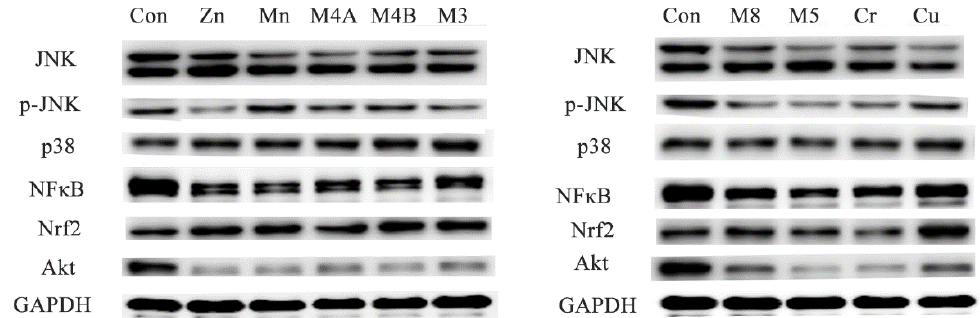
Figure 7. Signal protein expressions in the brain tissue. Abbreviations: Con, control group; M8: the mixture of eight common metals (Pb + Cd + Hg + Cu + Zn + Mn + Cr + Ni); M5: the mixture of five non-essential metals (Pb + Hg + Cd + Ni + Cr); M4A: the mixture of four non-